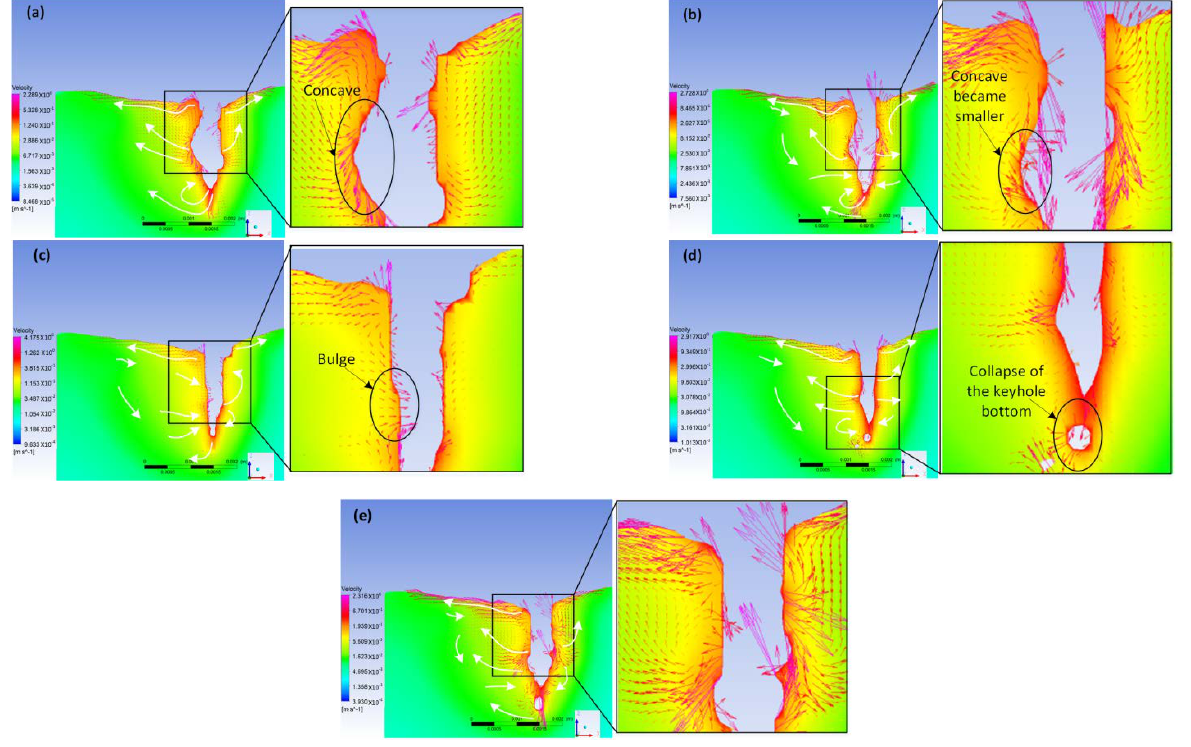
Figure 9. The melt flow behavior in the molten pool with preheating temperature of 500 K: ( a ) t = 28